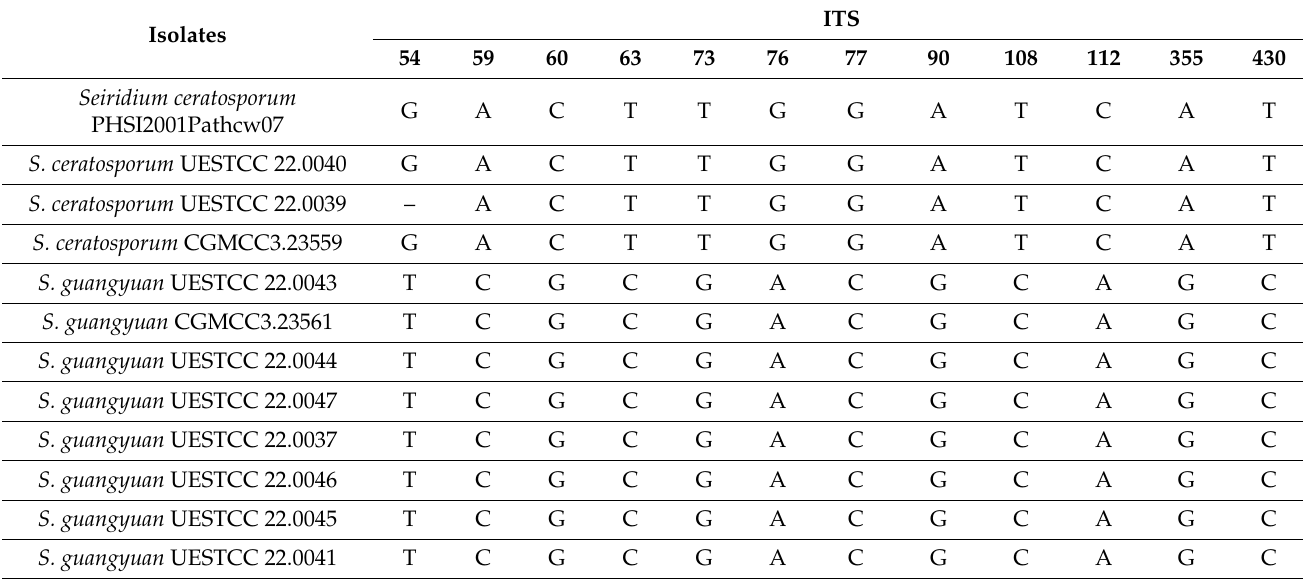
Table 3. Nucleotide variations in the ITS regions of the strains of Seiridium ceratosporum and the strains of S. guangyuanum